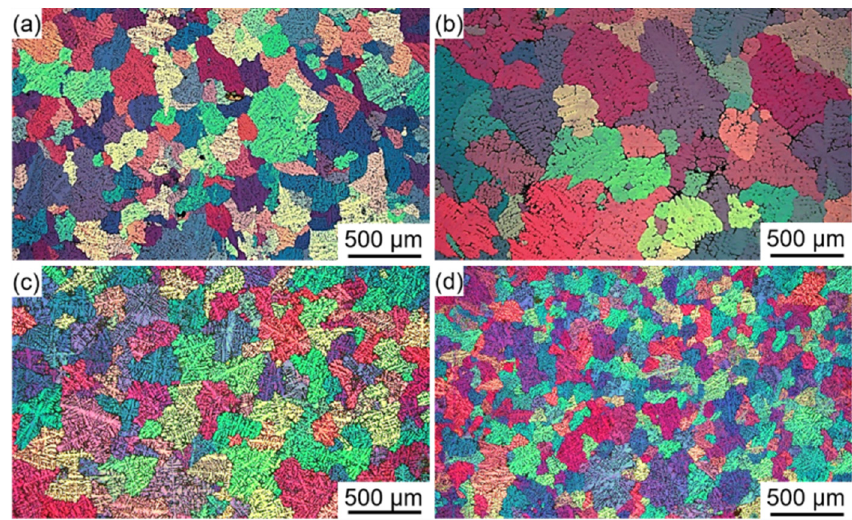
Figure 8. ( a ) Solidification microstructure of the Al–6Mg alloy in the roll-shoe gap obtained by shutdown sampling; ( b – d ) solidification microstructures of Al–6Mg alloys with different cooling rates (5 K/s, 10 K/s, and 20 K/s) obtained by traditional metal mold casting.